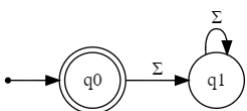
Figure 4. DFA approximating N 1 ⊕ N 2 .